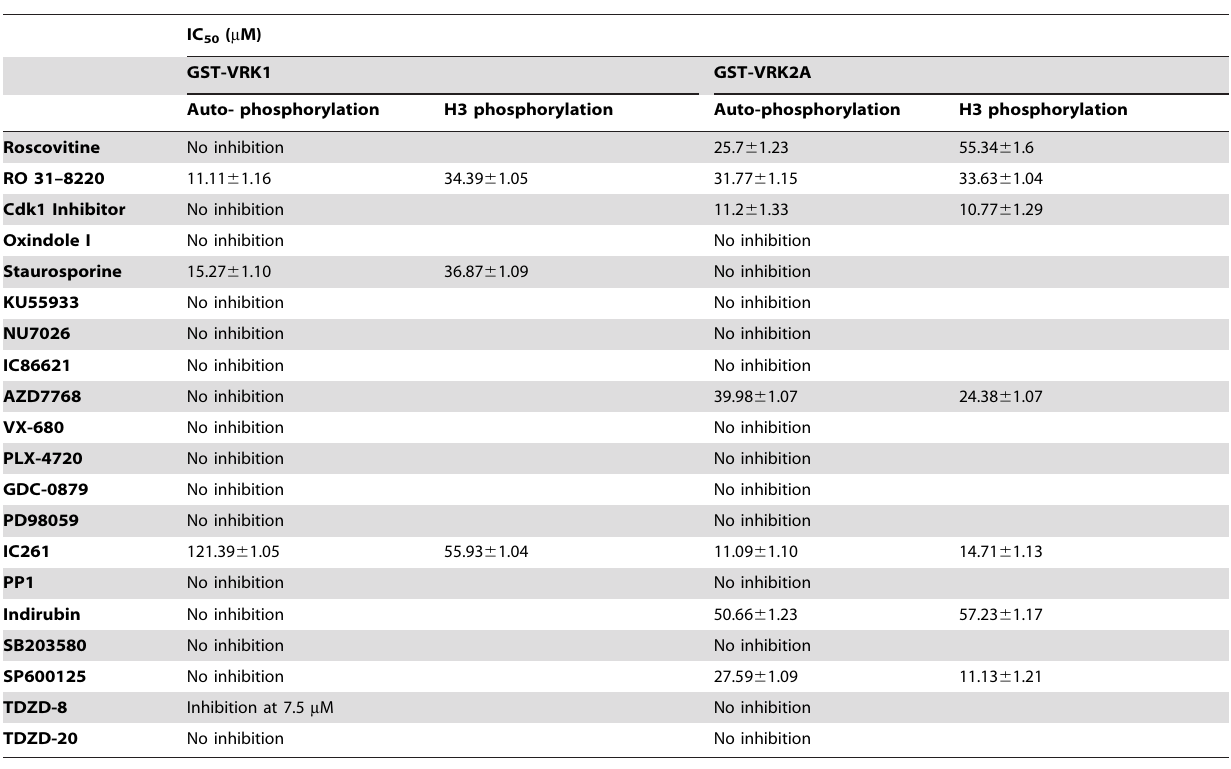
Table 1. VRK1 and VRK2A sensitivity and IC50 values of serine-threonine kinase inhibitors.